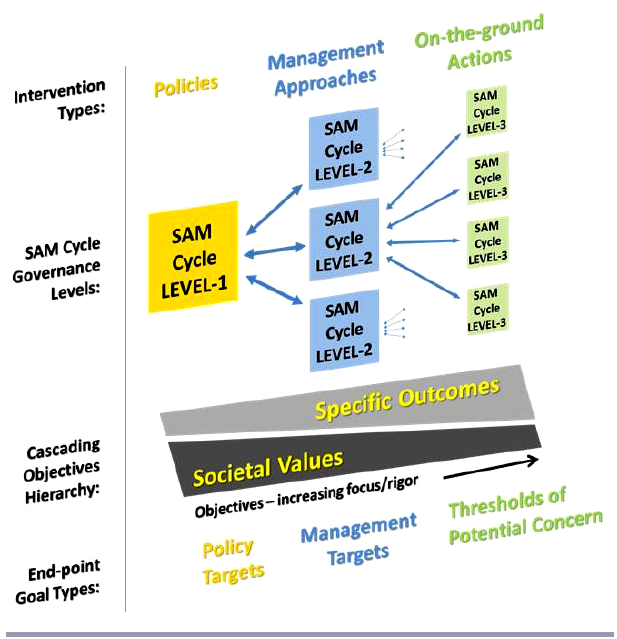
Fig. 3 . The nested distribution pattern of strategic adaptive management (SAM) cycles across governance Level-1, Level-2, and Level-3 of the SAM Reflexive Learning Framework (SRLF), applicable to each SRLF entity theme (Environment, Economic, and Community/Social). Intervention type, governance level, spread of Objectives, and End-point Goal types are also indicated. Notably, there is increasing focus and rigor of the Objectives from Level-1, through Level-2 into Level-3, characterized by a decrease in societal values and an increase in detail of the end-point goal outcomes. Arrows (blue) between governance levels represent critical vertical feedbacks required in SRLF (“top-down” and “bottom-up”).